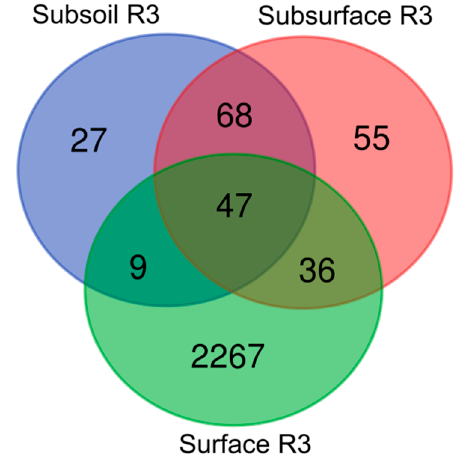
Figure 3. Beta-diversity of bacterial genera in the studied soil profiles (R1, R2, R3). The numbers included in the Venn diagrams refer to the occurrence of the identified genera representing the unique and shared core microbiome in the surface, subsurface and subsoil of studied soil profiles.